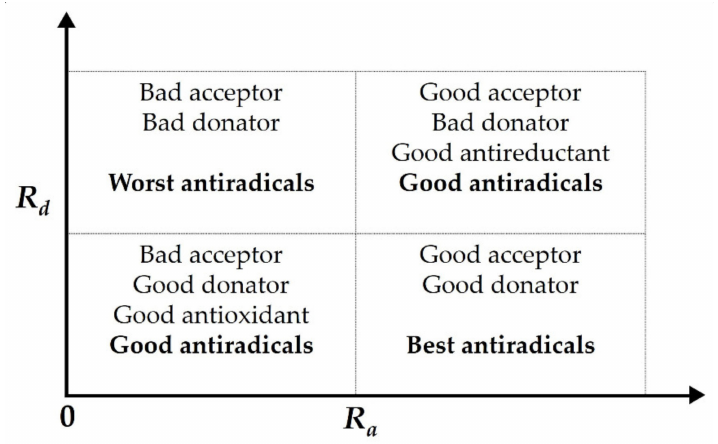
Figure 5. Donor-acceptor map (DAM). Adapted from [26,43].